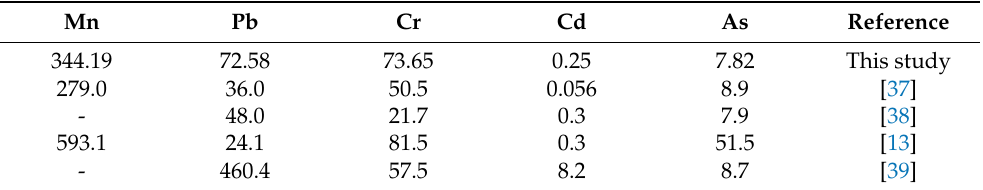
Table 3. Comparison of metal(loid)s concentration in soil in this study with background values and those from other studies